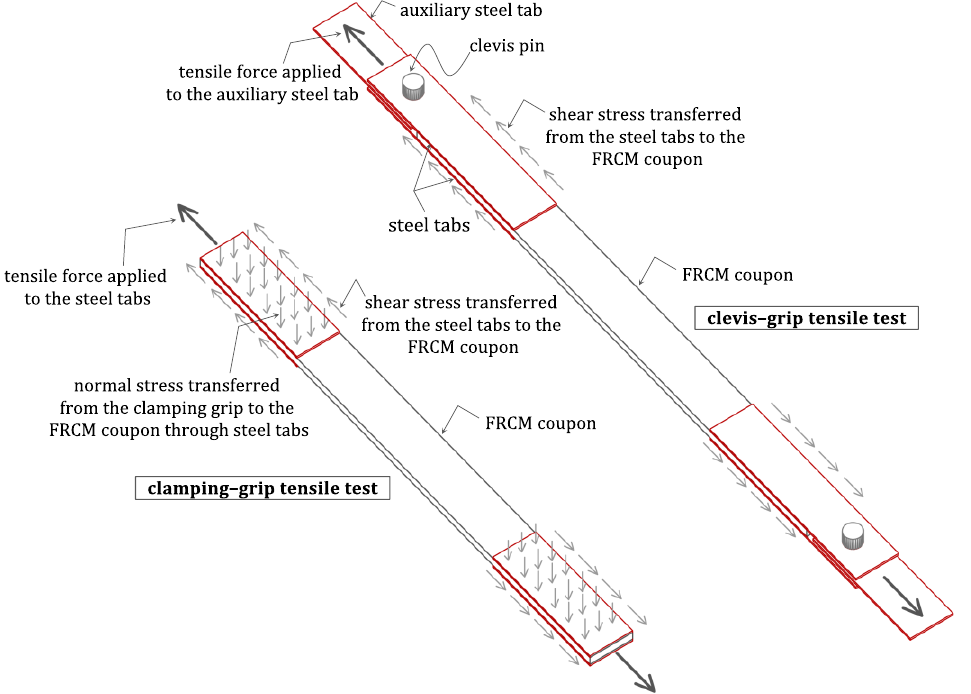
Figure 1. Tensile tests on FRCM coupons through clamping-grip (Italian guidelines CNR-DT 215/2018 [27]) and clevis-grip (US guidelines AC434 [28] and ACI 549 [1]) loading configurations.